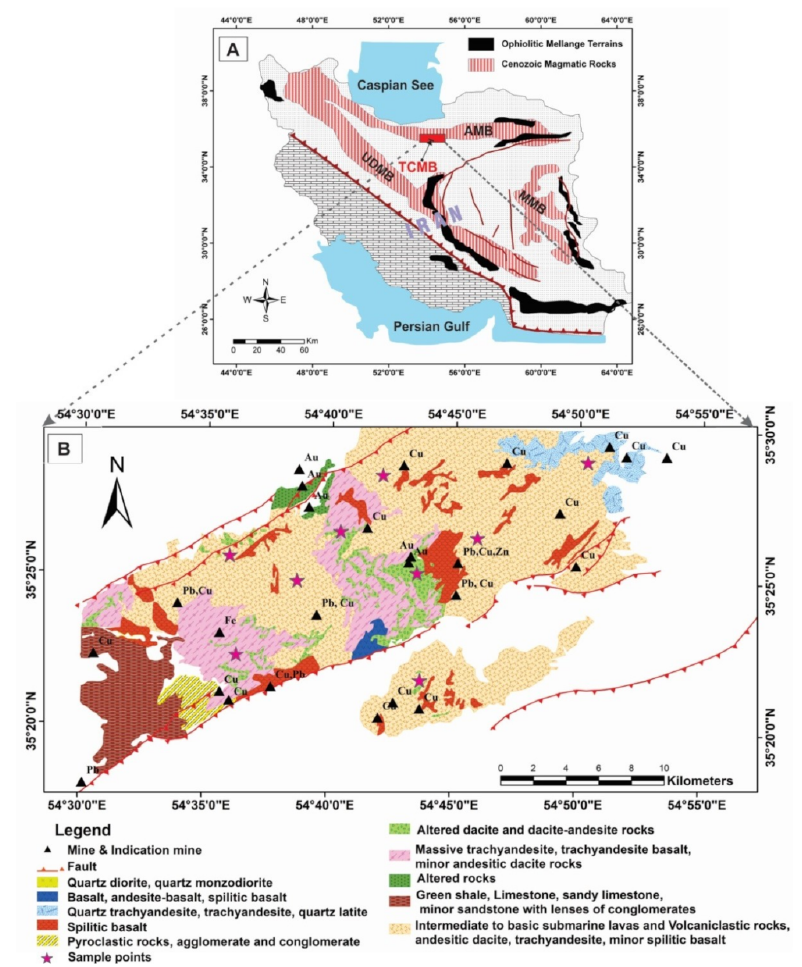
Figure 1. ( A ) The geographical location of the Toroud–Chahshirin Magmatic Belt (TCMB) in North of Iran (red rectangle). ( B ) Simplified geological map of the Moaleman region showing the distribution of polymetallic vein-type mineralization (modified from [42]). Abbreviations: UDMB: Urumieh–Dokhtar Magmatic Belt; MMB: Makran Magmatic Belt; AMB: Alborz Magmatic